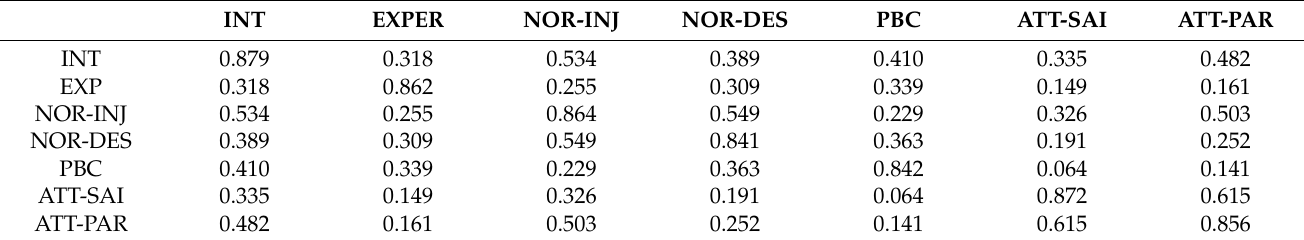
Table A3. Discriminant validity of the latent variables.